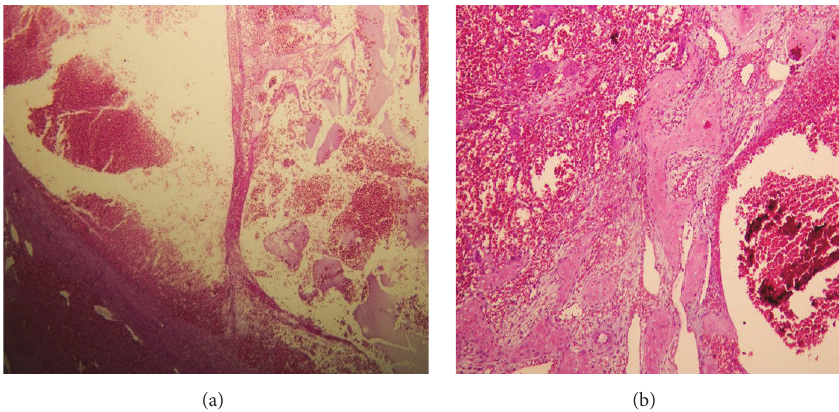
Figure 5: Histopathology photomicrograph. (a) Hematoxylin and eosin stained tissue sections of the mandibular lesion [HPF × 40]. (b) H&E stained tissue sections of the maxillary lesion show new bone formation, hemorrhage, giant cells, and sinusoid space in cellular fibrous connective tissue background [HPF ×